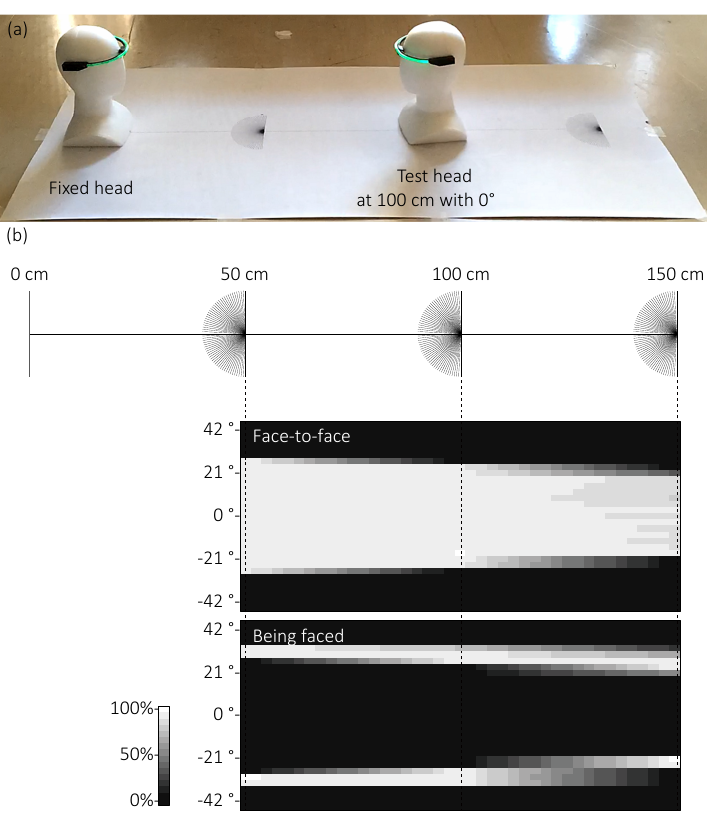
Figure 8. Evaluation of detection range: ( a ) A pair of dummy heads with our prototype devices were placed on a paper with a 150-cm ruler with 50-cm markings, and three protractors with 3 ◦ resolution. One head ( left ) was fixed, and the other ( right ) test head was rotated in 3 ◦ steps. We recorded the duration of the states of the device on the test head under three distances: 50, 100, and 150 cm. ( b ) Frequency of two states (BF, FtF) vs. angle of the test head for 60-s measurement (data values between the protractors are linearly interpolated). The 33.3% threshold for detecting FtF under 50, 100, and 150 cm conditions are 27.0 ◦ , 24.0 ◦ , and 18.0 ◦ ,